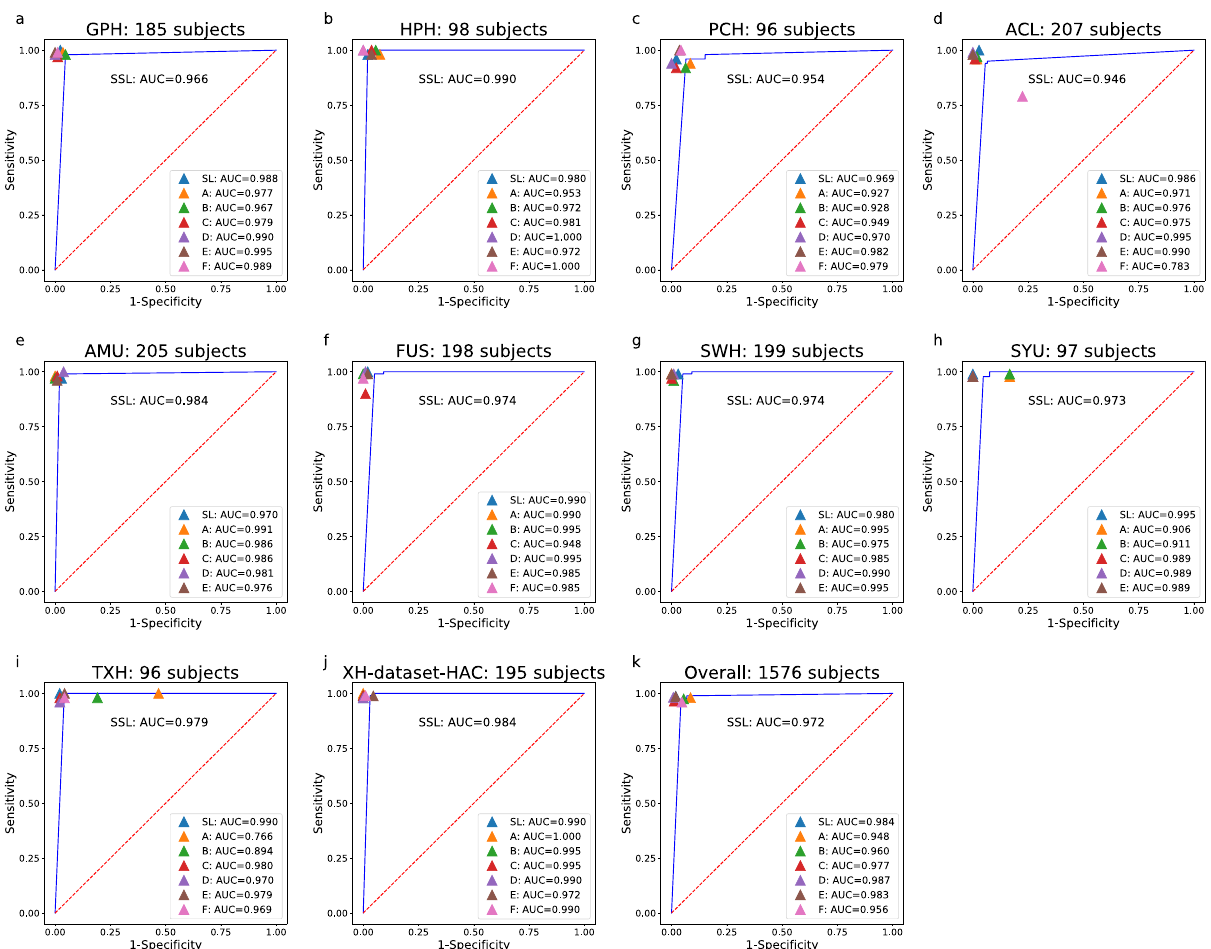
Fig. 4 The Human-AI CRC competition results. Area under the curve (AUC) comparison of Model-10%-SSL(SSL), Model-70%-SL(SL) and six pathologists ( a – f ) using Dataset-HAC, which consists XH-dataset-HAC, PCH, TXH, HPH, ACL, FUS, GPH, SWH, AMU and SYU. Blue lines indicate the AUCs achieved by Model-10%-SSL. The F pathologist did not attend the competition of SYU, AMU, and SWH data